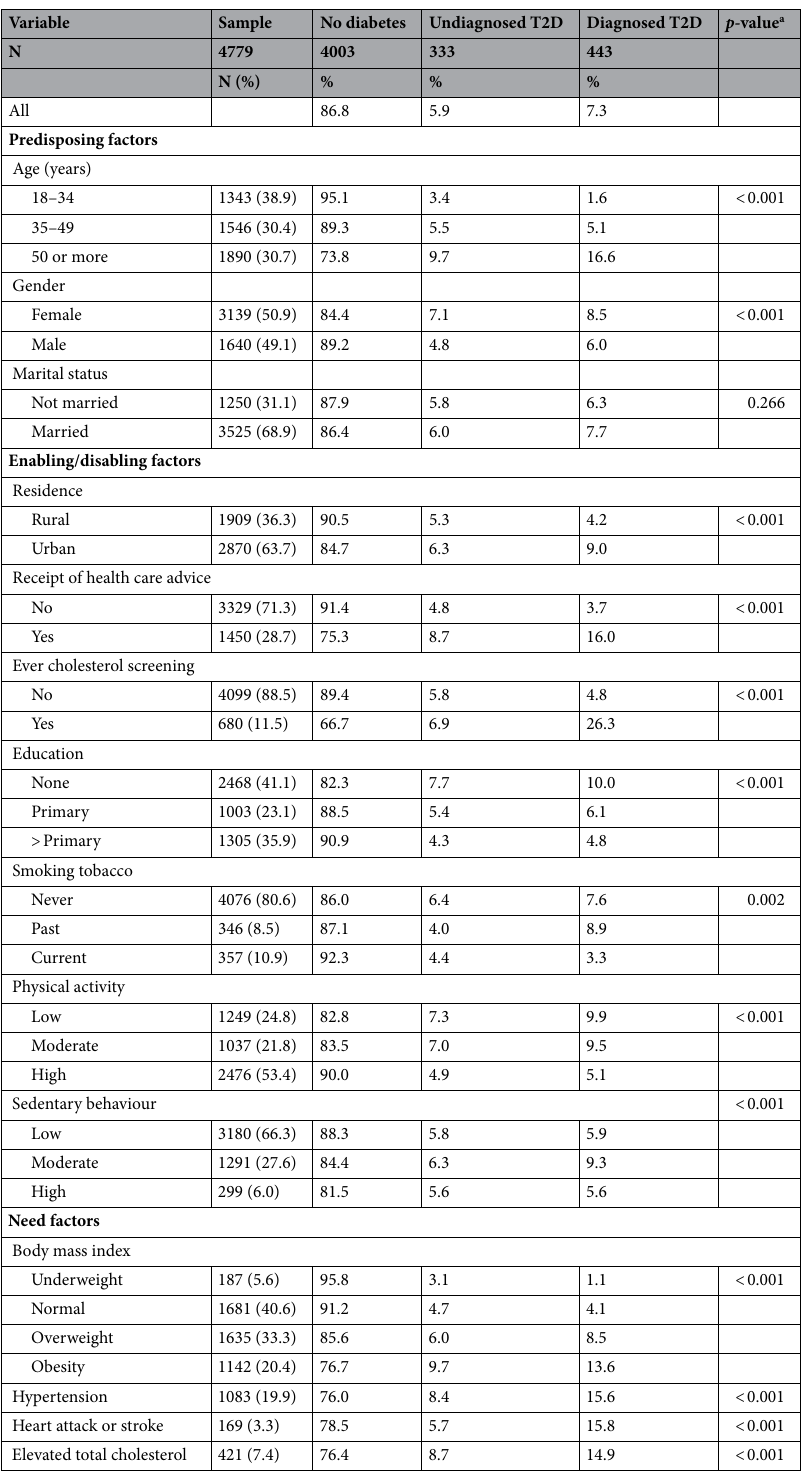
Table 1. Characteristics and predisposing, enabling/disabling and risk factors in a sample of 4779 adults screened for diagnosed and undiagnosed diabetes in Morocco, 2017. a Based on chi-square